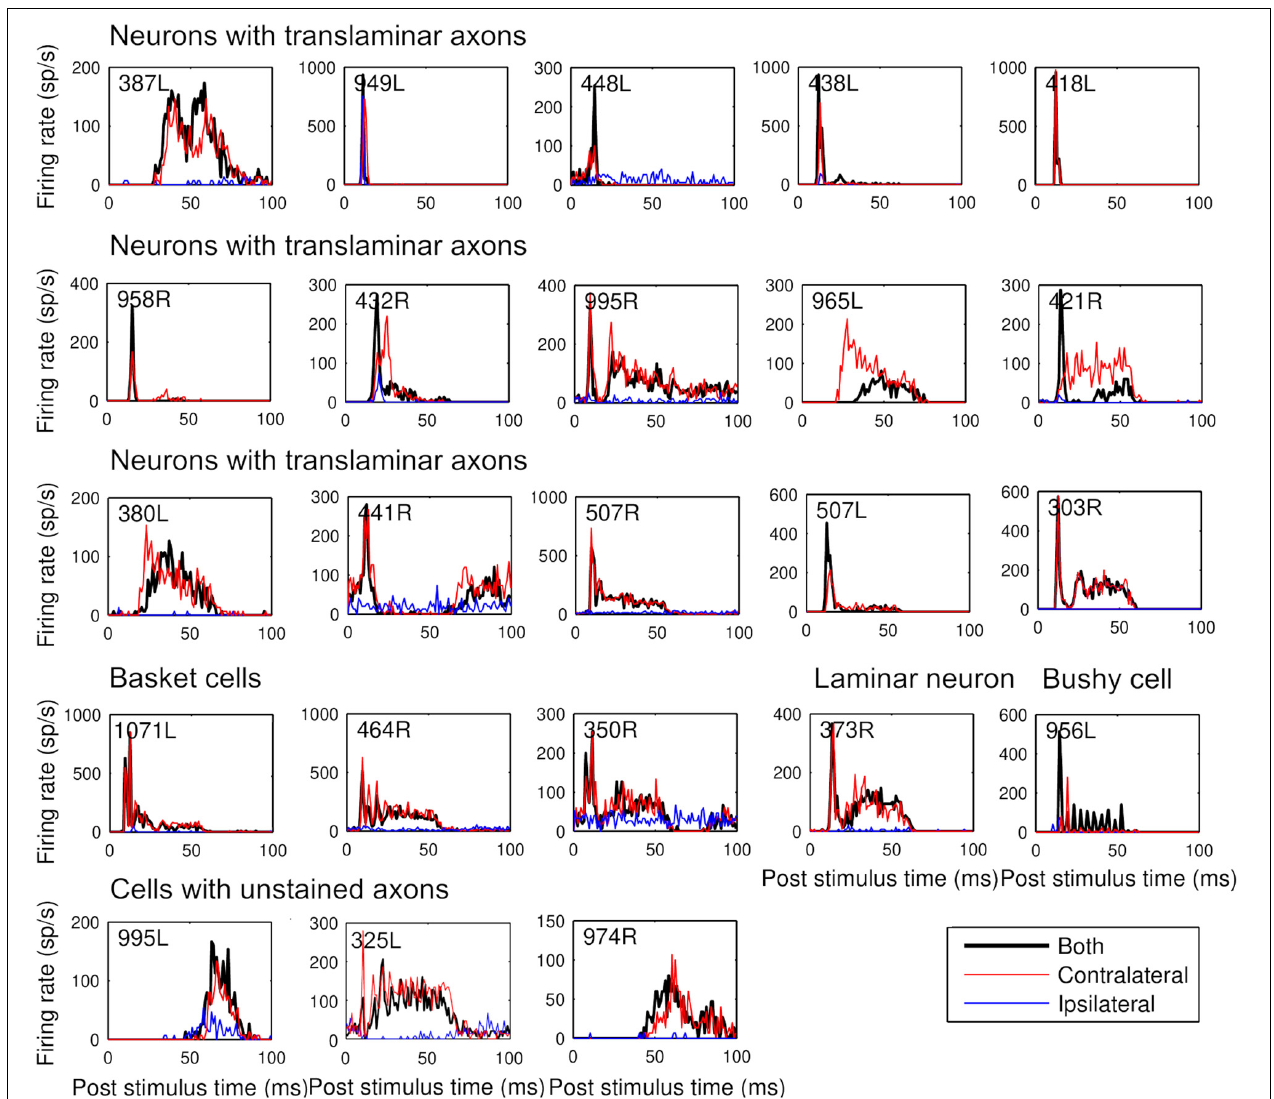
FIGURE 4 | Peristimulus time histograms to 50 ms CF tones arranged, in the same order as Table 1 . Tones were presented binaurally (black) contralaterally (red) and ipsilaterally (blue) at 20 dB above minimum threshold. Binwidth is 1 ms.